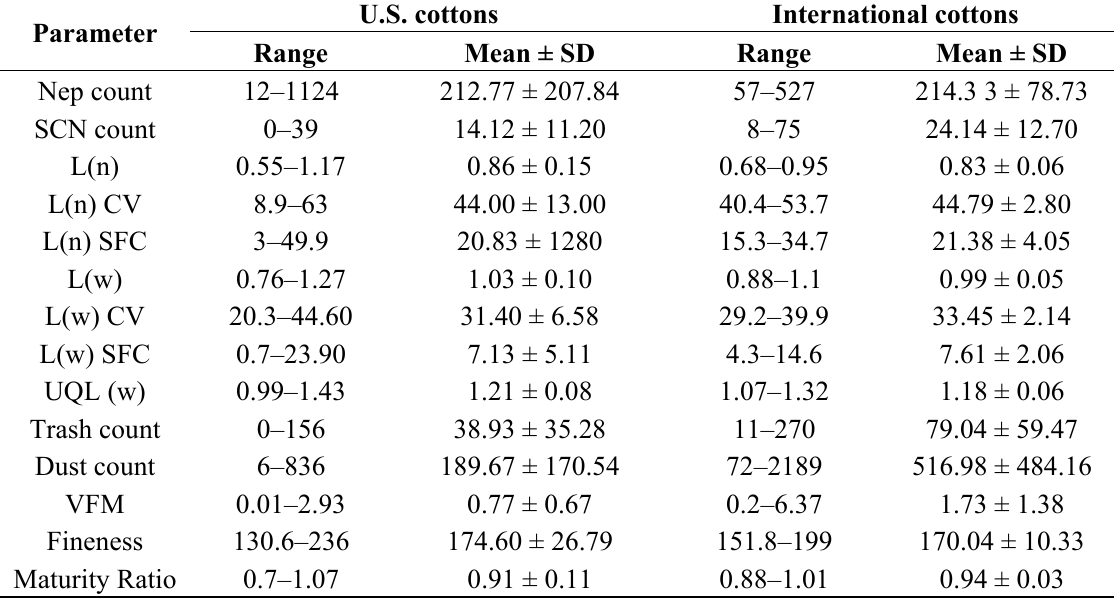
Table 1. Advanced Fiber Information System (AFIS) Data for U.S. and international